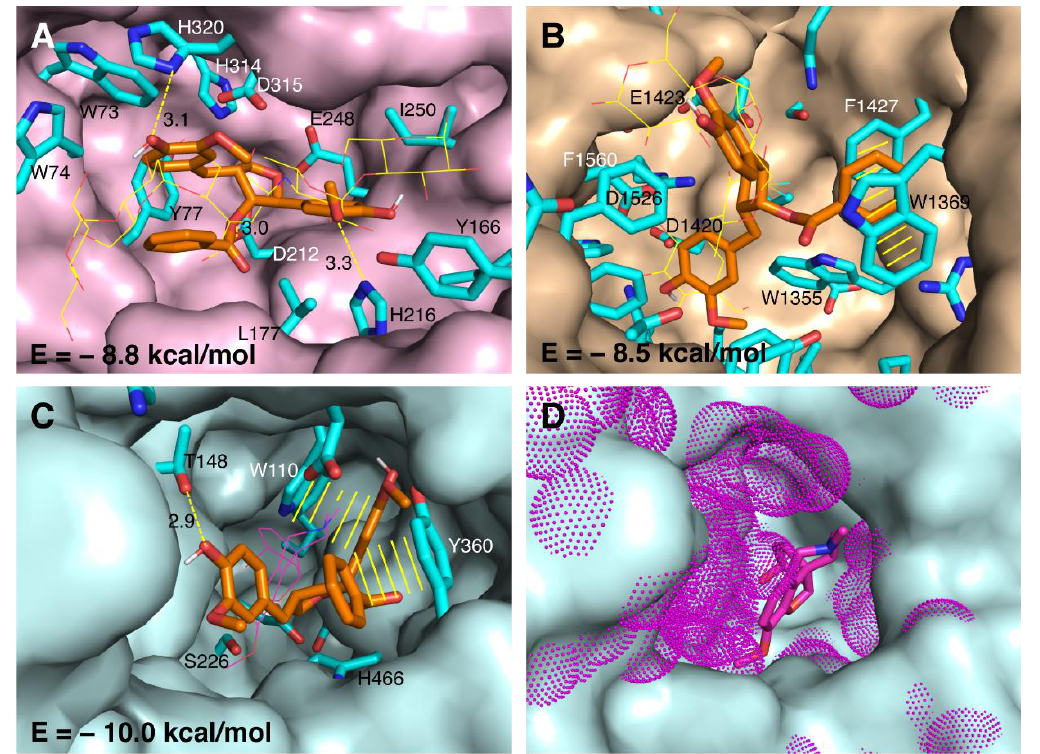
Figure 3. Docking of rhanteriol in the structures of α -amylase, α -glucosidase and in the homology model of BuChE. The binding pockets of α -amylase (pink surface in ( A )), α -glucosidase (beige surface in ( B )), BuChE (light cyan surface in ( C ) and ( D )) and AChE (additional density with respect to BuChE in magenta-dot surface in ( D )) with rhanteriol interacting-residues in sticks (cyan carbons). Rhanteriol is shown in sticks (orange carbons), acarbose in lines (yellow carbons) and galantamine in lines/sticks (carbons in magenta). The hydrogen bonds are indicated with dashed yellow lines and the distances in Å, and π - π interactions with solid yellow lines. The binding energies (E) of rhanteriol, obtained by Autodock vina, are indicated for each protein.